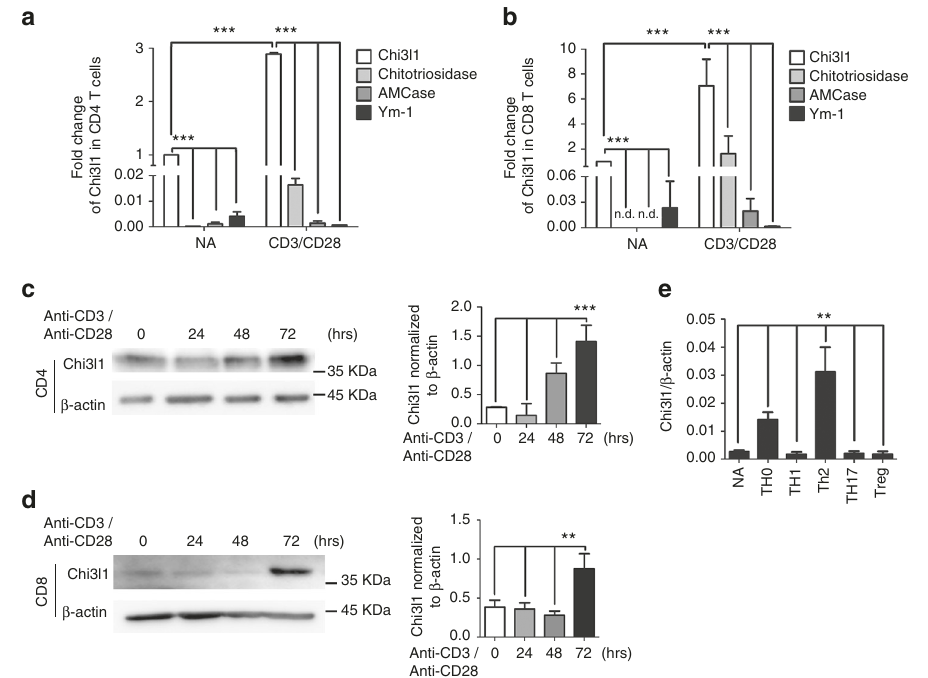
Fig. 1 Chitinase and Chitinase-like protein expressions in T cells. a , b mRNA expression of chitinase (Chitotriosidase, AMCase) and chitinase-like protein (Chi3l1, Ym-1) in mouse CD4 and CD8 T cells upon anti-CD3 and anti-CD28 stimulation for 3 days. Each gene expression level was normalized to β -actin, and represented as fold change to Non-activated (NA). c , d Chi3l1 protein level in CD4 and CD8 T cells stimulated by plate-bound anti-CD3 and anti-CD28 antibodies for indicated time point. Densitometric values of band intensity were calculated by normalization to the value of β -actin. e Chi3l1 mRNA expression in naïve and effector T cell subsets. Chi3l1 mRNA expression level was normalized to β -actin level. Data are mean ± SD of three sets of independent experiments ( n = 6). n.d., not detected; ** p < 0.01, *** p < 0.001 (two-tailed Student ’ s t (Fig. 5d). Expression of SOCS1, a phosphatase that inhibits phosphorylation of STAT1, was signi fi cantly decreased without differences in SOCS3 and SOCS5 in Chi3l1-de fi cient Th1 cells compared to WT Th1 cells. Twist1, a Th1 inhibitory molecule, was also reduced, presumably explaining how Chi3l1 KO Th1 cells produce more CTSE, TRAIL, IFN γ , and CXCR2. The molecular expression patterns were the same in CD8 T cells (Fig. 5e). In addition, activated Chi3l1 KO CD8 T cells expressed higher levels of T-bet, IFN γ , Perforin, and Granzyme B, sug- gesting that Chi3l1 KO CD8 T cells induce high levels of effector molecules related to CTL function. Taken together, these results suggest Chi3l1 is a negative regulator of gene expressions regarding Th1 and CTL functions. Chi3l1 de fi ciency in T cells inhibits pulmonary metastasis . The increase of effector functional molecules in Chi3l1-de fi cient T cells prompted us to investigate whether Chi3l1-de fi cient Th1 and CTL contributed to anti-tumor immunity. To test our hypothesis, we utilized B16F10 melanoma lung metastasis model.